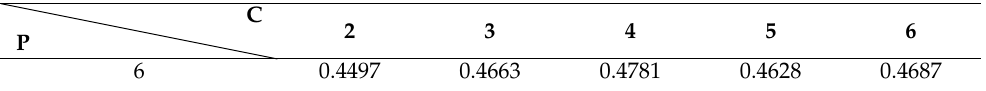
Table 5. Prediction performance of the optimized CGK-based fuzzy granular model.